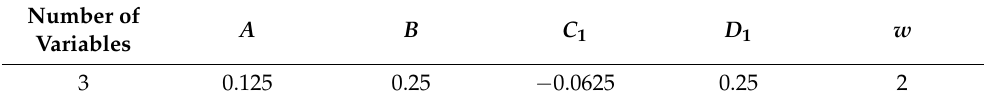
Table 6. The values of the